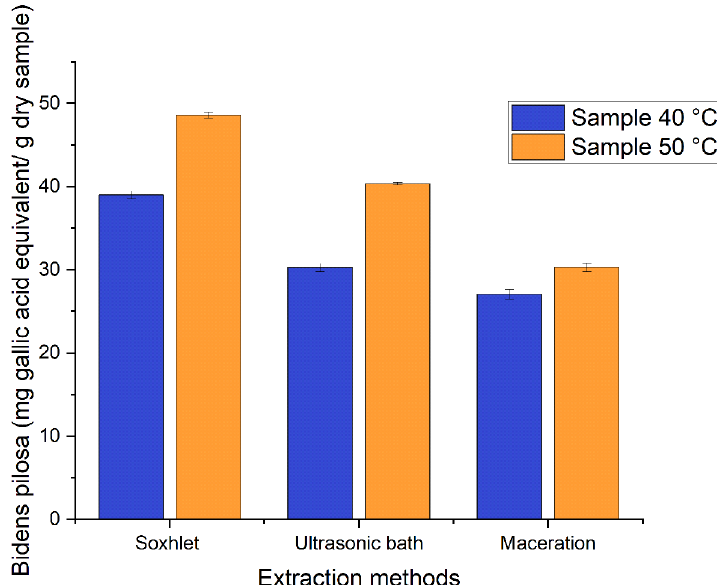
Figure 9. Phenolic content of the different ethanolic extracts of Bidens pilosa Table 6. Total phenolic content corresponding to the equivalent of gallic acid.